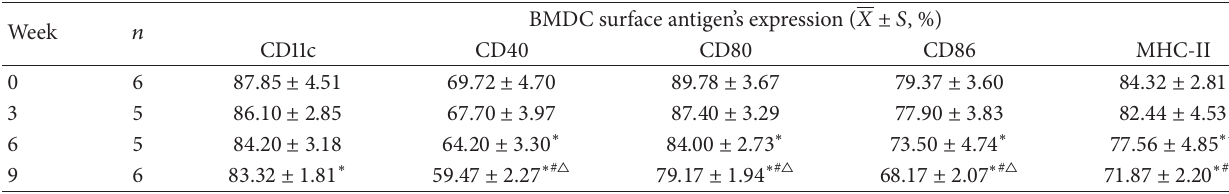
Table 5: BMDC surface antigen’s expression of MTX combined with CTX